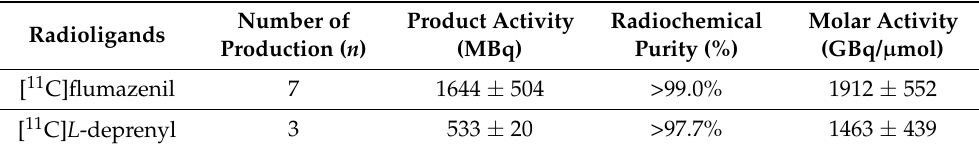
Table 1. Summary of [ 11 C]flumazenil and [ 11 C] L -deprenyl production.